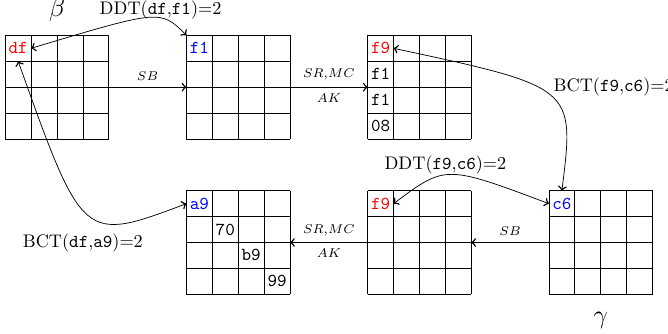
Figure 5: A 2-round E m example for AES , with the actual β and γ values, which will never generate a right quartet. The differences are represented in